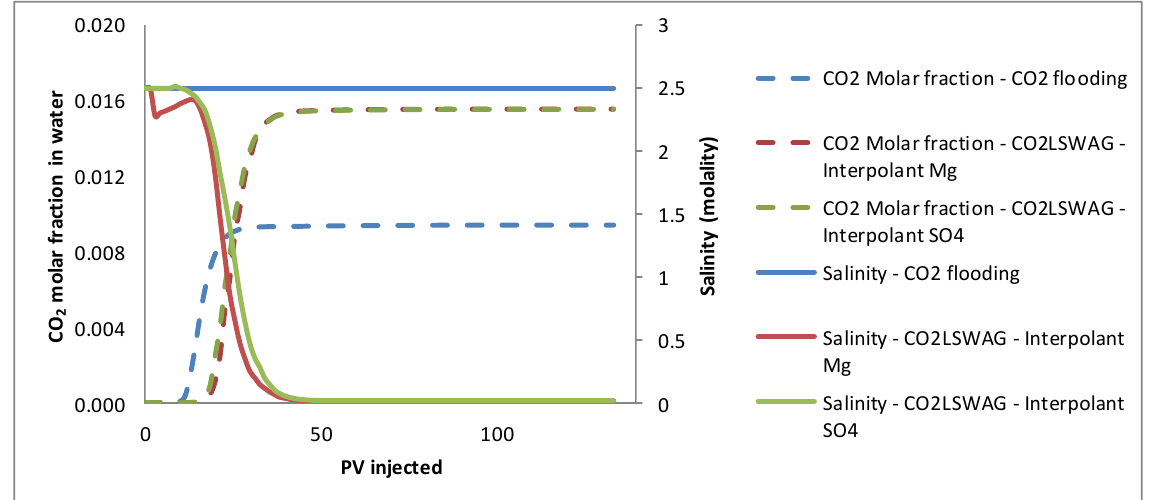
17 of 24 Figure 12. Results of pH and Mg 2+ and SO 42 − concentration in the effluent for continuous CO 2 injec- tion and CO 2 -LSWAG considering Mg and SO 4 as ion interpolants. Figure 13 shows the effluent salinity curves in line with the results discussed. There is a dilution of the aqueous phase for CO 2 -LSWAG due to brine injection with a lower concentration of salts than the formation water initially present in the core. Data on CO 2